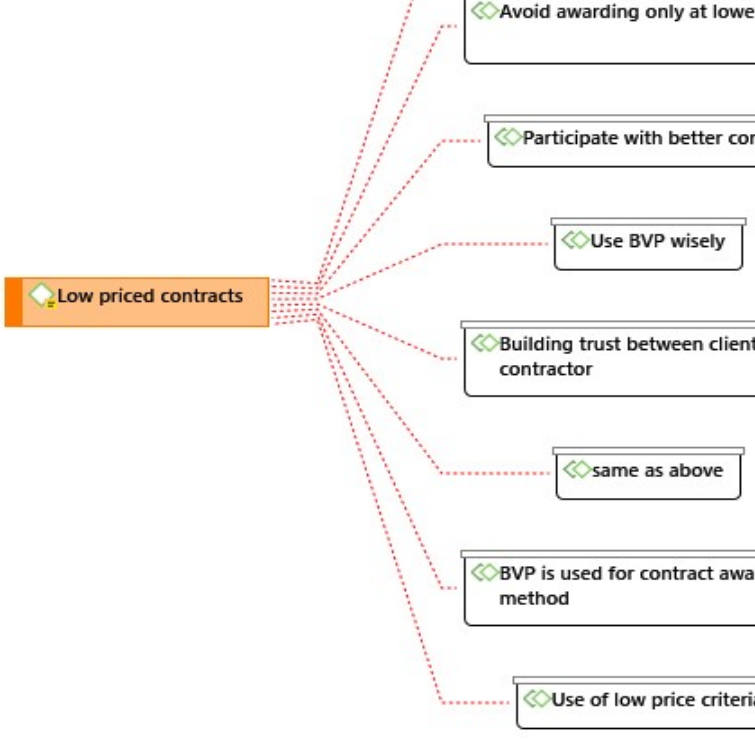
Figure 7. Thematic map 4.